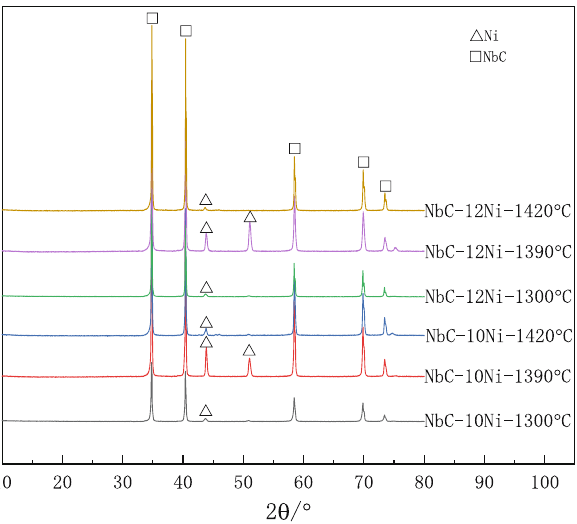
Figure 7: XRD di ff raction spectra of raw materials and NbC – Ni cer - mets at di ff erent sintering temperatures.